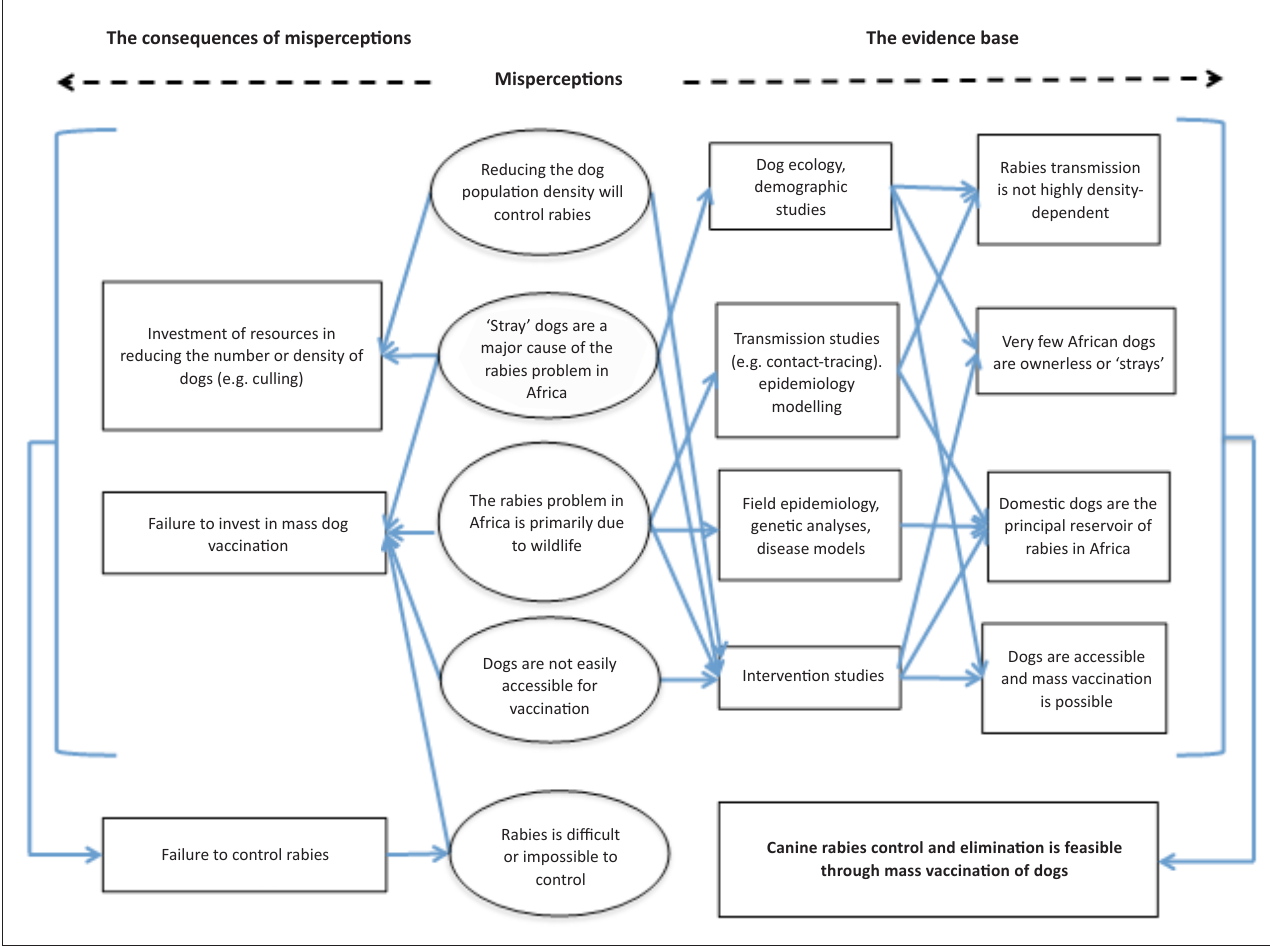
FIGURE 1: Scheme showing how misperceptions about dog ecology and rabies epidemiology have negative consequences for rabies control; and identifying the types of research studies that can generate the evidence-base needed for effective control.